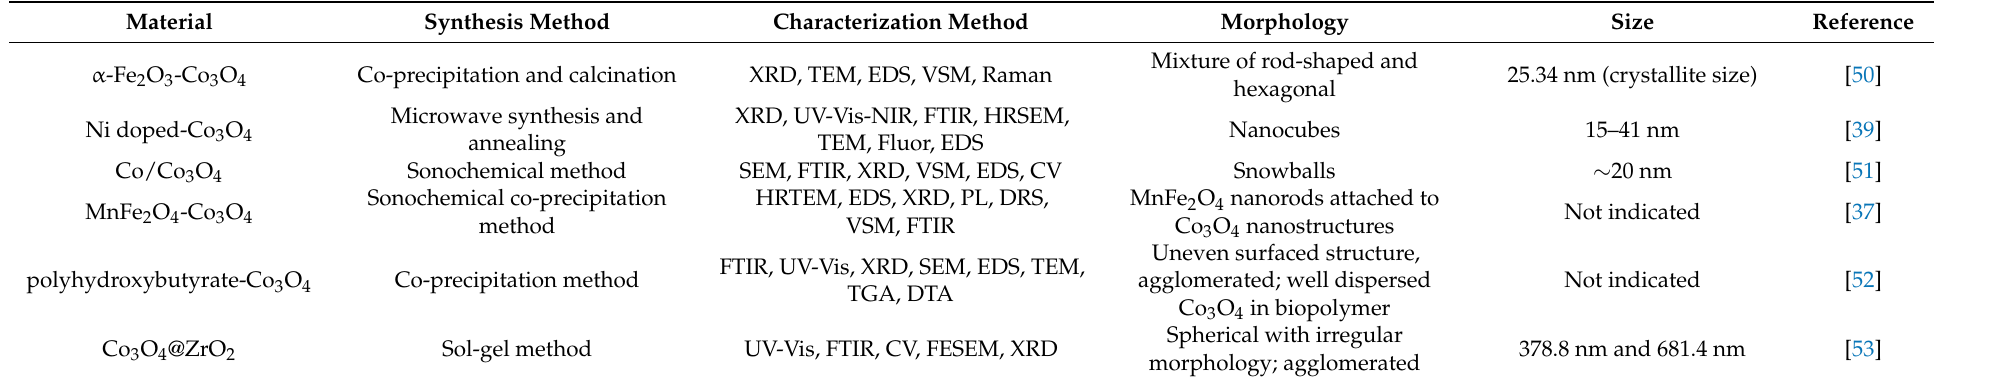
Table 2. Synthesis, characterization, and characteristics of cobalt oxide